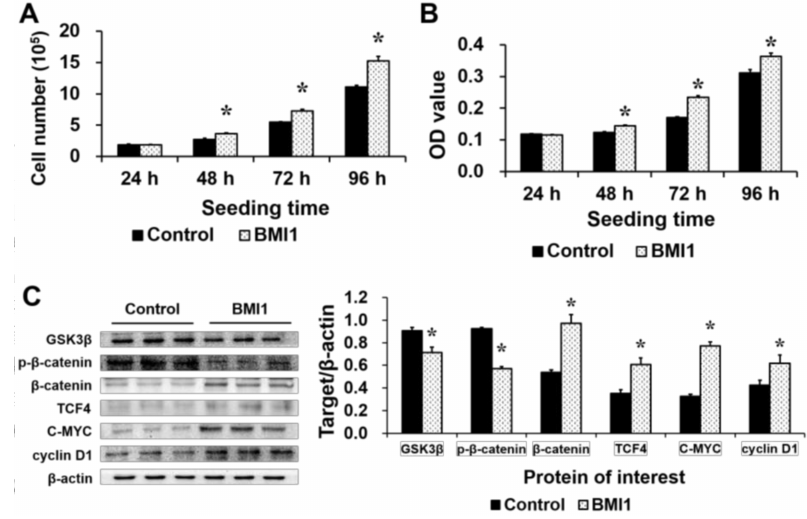
Figure 5. The effects of BMI1 overexpression on cell proliferation and WNT/ β -catenin signaling-related protein expression in IPEC-J2 cells. ( A ) The cell number was higher in the BMI1 -overexpressing group than in the control group at 48, 72 and 96 h after seeding, as assessed by the cell count assay ( n = 3); ( B ) The OD value was higher in the BMI1 -overexpressing group than in the control group at 48, 72 and 96 h after seeding, as assessed by the MTT assay ( n = 20); and ( C ) The levels of WNT/ β -catenin signaling-related proteins were assessed by Western blot ( n = 3). The results were confirmed by three independent experiments per treatment. Representative results of the three independent experiments are shown. The bars are the means ± SE, * indicates a significant difference ( p <